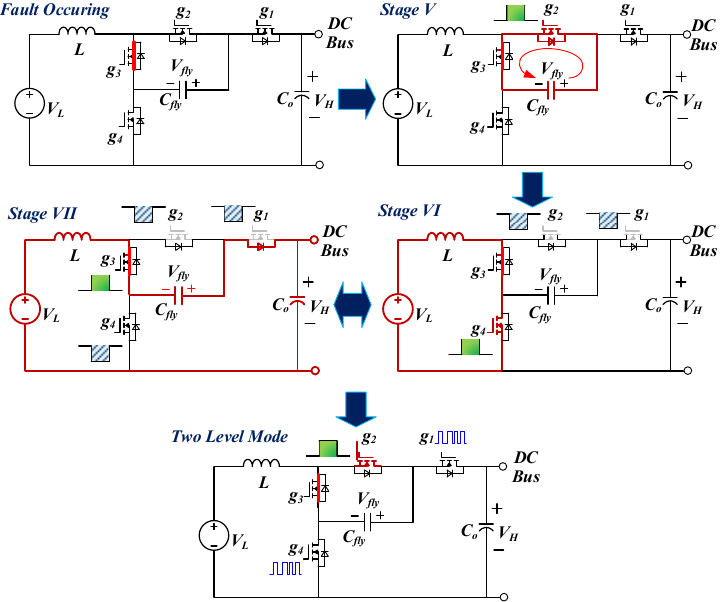
Figure 6. Stages of capacitor voltage control mode after short-circuit fault occurs in S 3 . The diagram in Figure 7 shows the key quantities under the situation in which the short-circuit fault occurs in the outer switch S 4 when V L is lower than 0.5 V H . Before the fault occurs, the converter operates in three-level mode. When the short-circuit fault of the switch S 4 is detected, the converter begins to operate in flying capacitor voltage control mode. The flying capacitor voltage is regulated gradually from half of the output voltage to output voltage. When the flying capacitor voltage reaches the output voltage, the converter turns to operate in two-level mode.